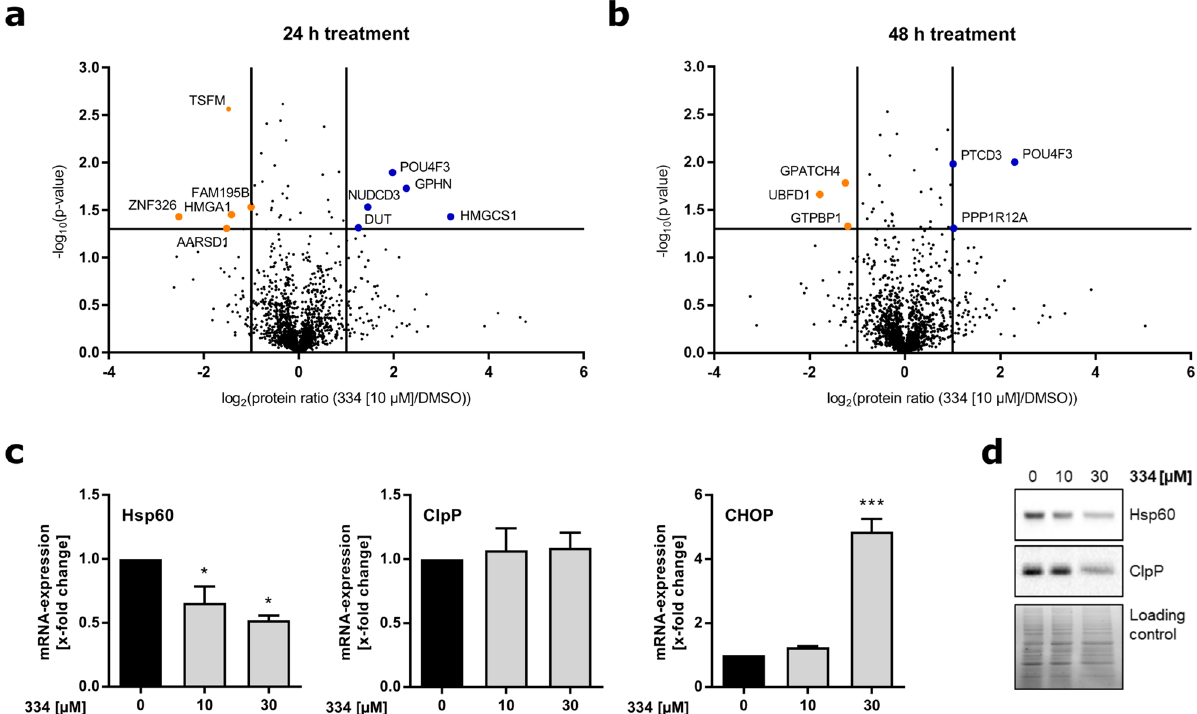
Figure 4. 334 induces cellular stress and alters the mitochondrial proteostasis. ( a ) Short-term 334 treatment (24 h) increases unfolded protein binding and decreases DNA repair. ( b ) Further, 334 treatment upon 48 h indicates the induction of the mtUPR. For (a) and (b) volcano plot analysis of quantitative MS-proteomics by SILAC are shown. Light, medium, and heavy isotope-labeled K562 cells were treated with 334 (10 µM) for the indicated time and compared to DMSO-treated controls (n = 3). Significantly enriched (blue) or depleted (orange) proteins are highlighted. Cut-off criteria: P < 0.05; |log 2 (334 [10 µM]/DMSO)|> 1. See also Supplementary Fig. S4a,b, Supplementary Tables S1 and S2 online. ( c ) 334 reduces Hsp60 mRNA expression and induces transcription of CHOP. mRNA levels of Hsp60, ClpP, and CHOP were assessed in 334-treated Jurkat cells after 24 h and normalized to untreated controls. Relative mRNA expression was assessed by normalization to mRNA of the housekeeping gene actin (* P < 0.05, *** P < 0.001, One-way ANOVA, Tukey’s Multiple Comparison Test, n = 3). ( d ) 334 treatment impairs Hsp60 and ClpP protein expression. Western blot analysis shows Hsp60 and ClpP protein levels in Jurkat cells after 334 treatment for 24 h (n = 3). Full length blots are presented in Supplementary Fig. S8